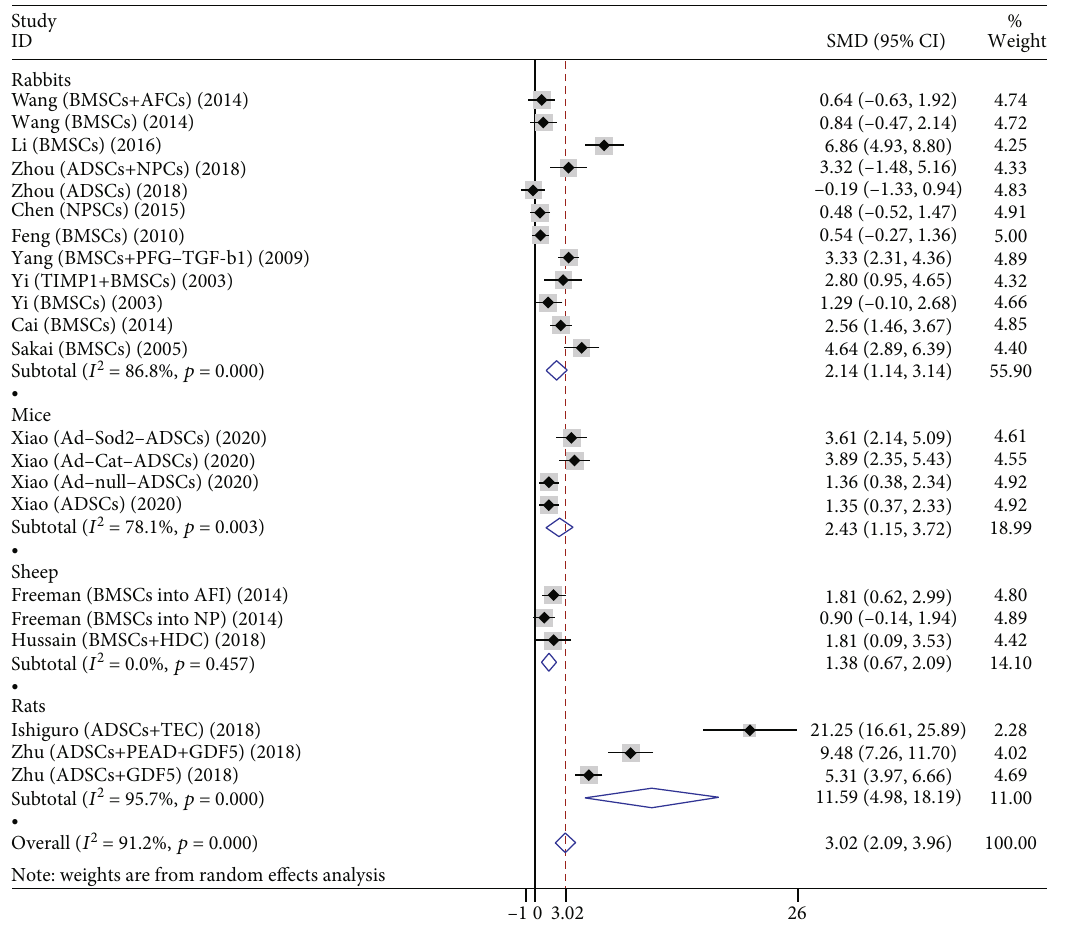
Figure 3: Forest plot showing the e ff ect of stem cell group and control group on DHI in animal